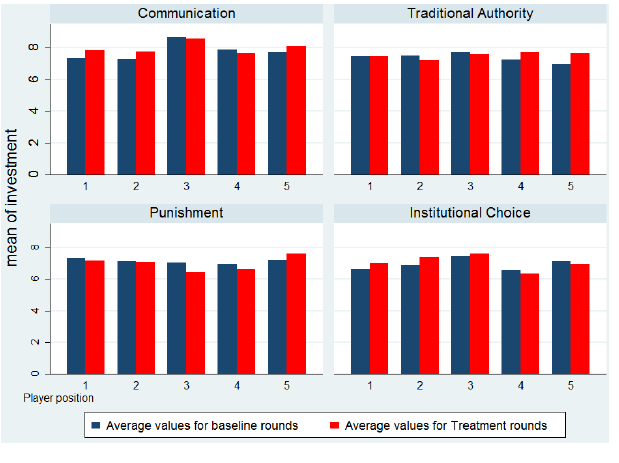
Fig. 8. Average investment depending on player position before and after the introduction of sanction treatments.